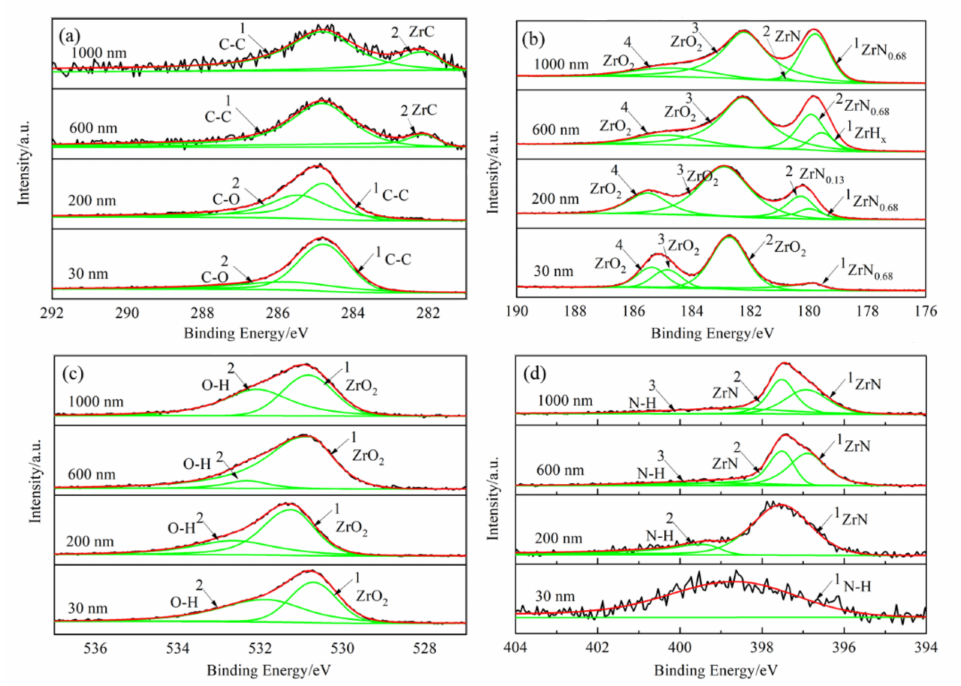
Figure 8. XPS narrow spectrum of C1s, Zr3d, O1s, and N1s at different sputtering depths. ( a ) C1s; ( b ) Zr3d; ( c ) O1s; ( d ) N1s.